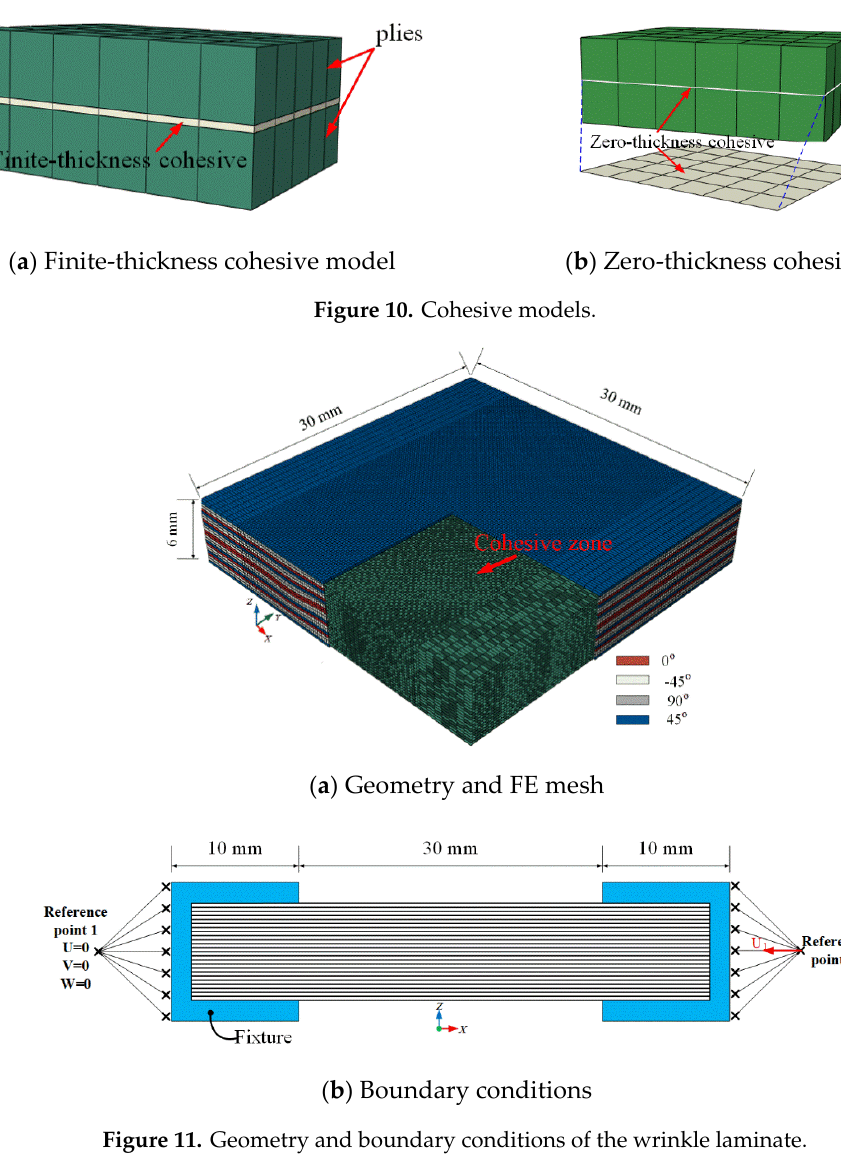
Figure 11. Geometry and boundary conditions of the wrinkle laminate.